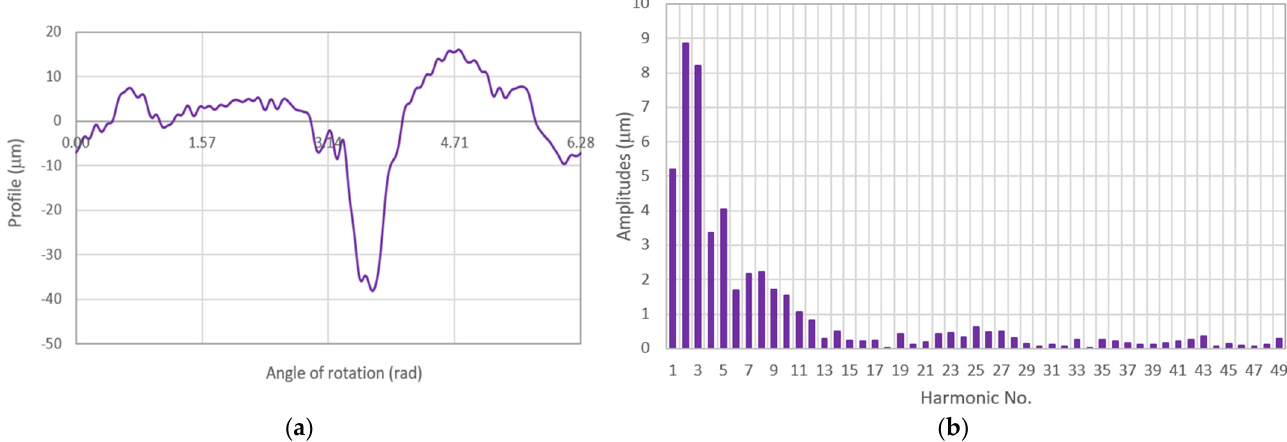
Figure 12. Measured summary profile of the journal No. 4 ( a ), and discrete amplitude spectrum ( b ).